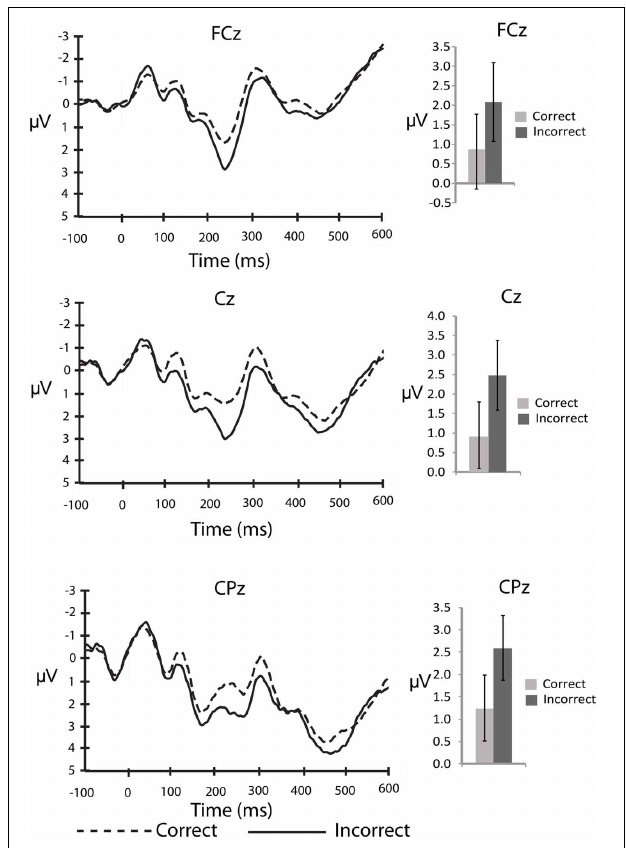
FIGURE 1 | Stimulus-locked, grand averaged waveforms for electrode sites: FCz, Cz, and CPz. Figure shows the average waveform for correct (dashed line) and incorrect (solid line) responses (panels on left side). The P2 component can be observed between 200 and 275ms post-stimulus. The panels on the right show the averaged amplitudes within the P2 window, with standard error bars. The N2 can be observed between 275 and 375ms